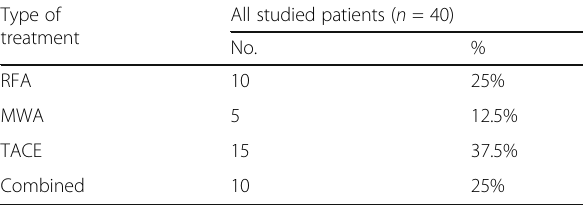
Table 5 Type of treatment of all studied patients Type of treatment